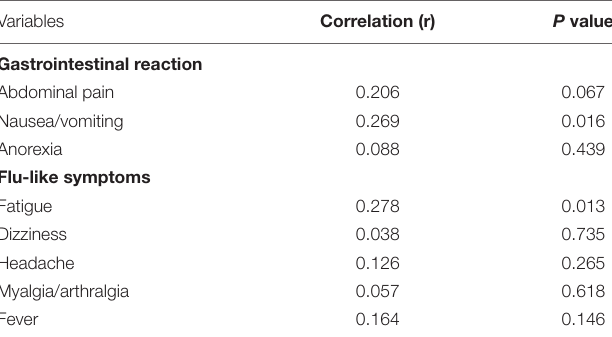
TABLE 5 | Linear regression analysis of day 1 sTREM-1 versus variables of adverse